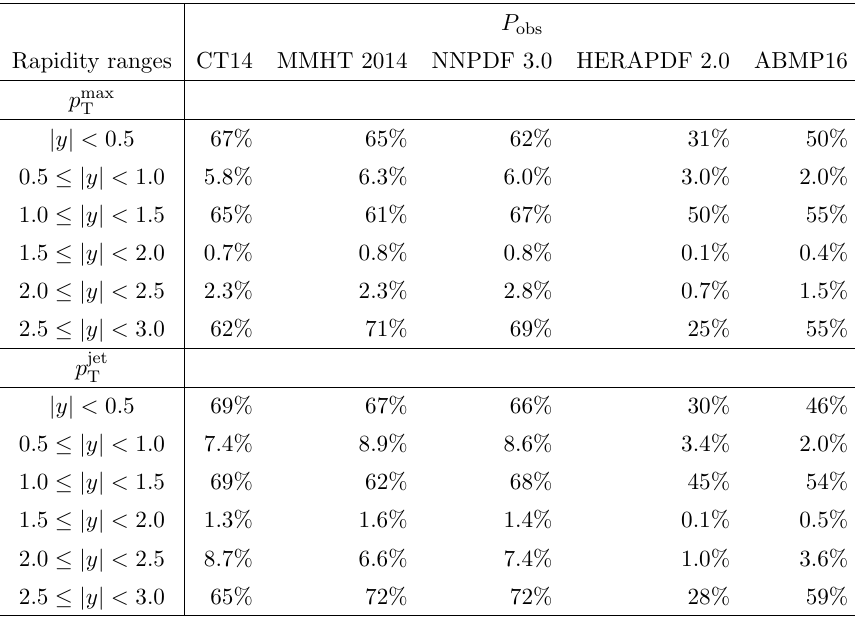
Table 2 . Summary of observed P obs values from the comparison of the inclusive jet cross-section and the NLO pQCD prediction corrected for non-perturbative and electroweak e(cid:11)ects for various PDF sets, for the two scale choices and for each rapidity bin of the measurement.